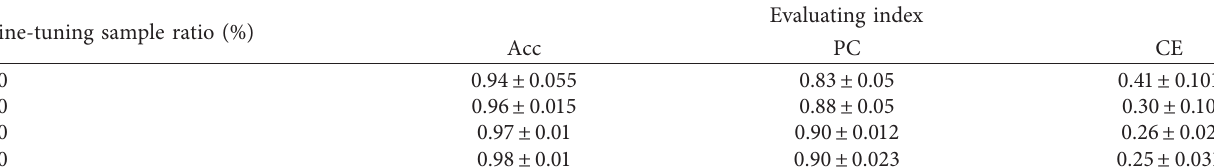
Table 2: Statistics of test results under different proportion fine-tuning samples.